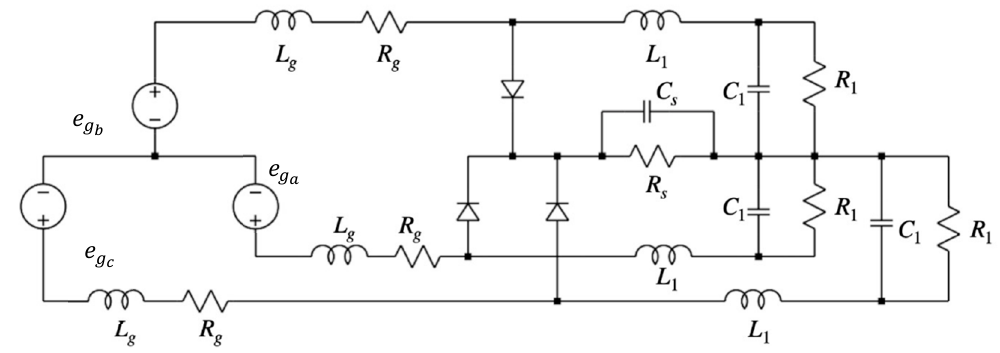
Figure 1. Three-phase circuit to be analyzed.